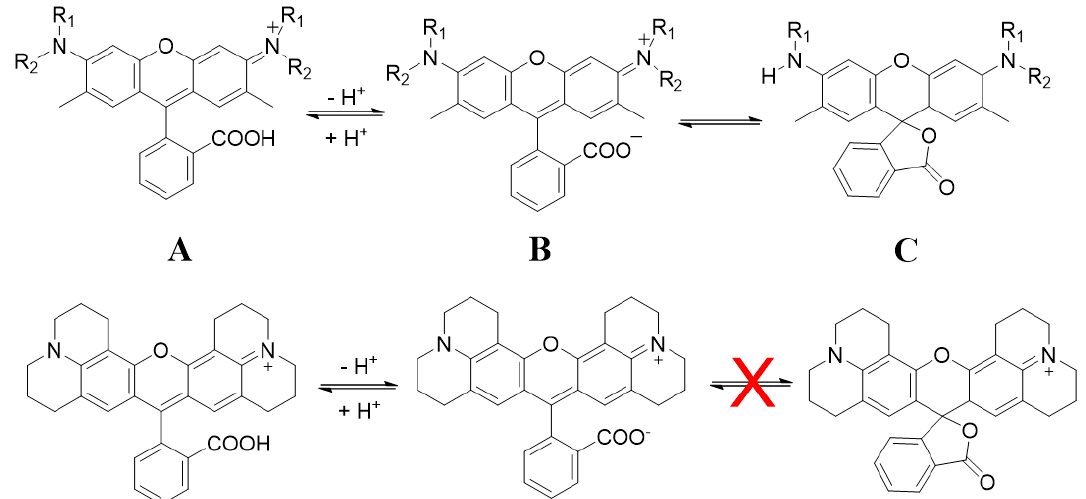
Figure 3. ( top ) General molecular structures of rhodamines in equilibrium and ( bottom ) structure of Rhodamine 101 (R101): cationic ( A ), zwitterionic ( B ), and lactone ( C ) forms.